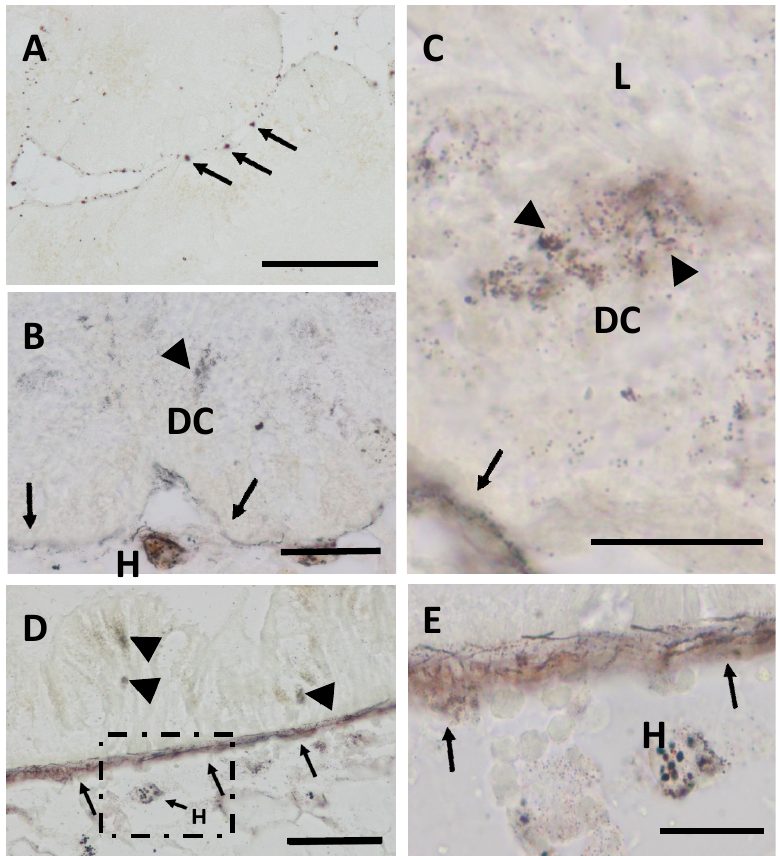
Figure 2. Autometallography staining of the midgut gland of winkles. ( A ) Controls, black silver deposits (BSD) in the basal lamina (arrows) of midgut gland tubuli (scale bar: 100 µm); ( B ) CdH (21 days), BSD in digestive cell lysosomes (arrowheads) and in the basal lamina (arrows) of midgut gland tubules. Note the presence of BSD within hemocytes (H) of the interstitial connective tissue (scale bar: 50 µm); ( C ) CdH (21 days), detail of BSD in digestive cell (DC) lysosomes (arrowheads) near the tubular lumen (L) and in the basal lamina (arrows) of a midgut gland tubule (scale bar: 20 µm); ( D ) CdH (21 days), BSD in the basal lamina of the epithelium of the stomach (arrows), in the lysosomes of epithelial cells (arrowheads) and in hemocytes (H) of the connective tissue (scale bar: 50 µm); ( E ) CdH (21days), inset of figure ( D ) (square), showing in detail BSD in hemocytes and in the basal lamina of the stomach epithelium (arrows).